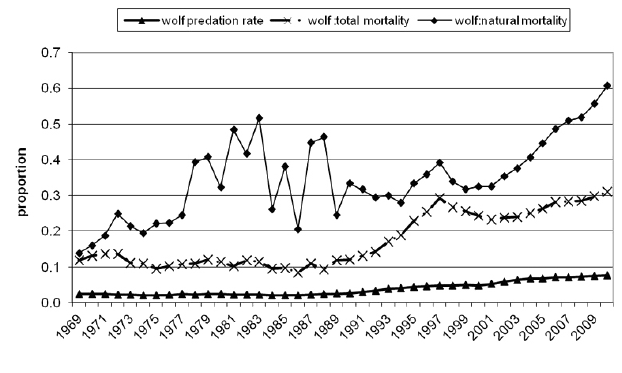
Fig. 8 . Predation rate by wolves where: “wolf predation rate” is proportion of total population size; “wolf:total mortality” is the proportion of total mortality attributed to wolves; “wolf: natural mortality” is the proportion of nonharvest mortality attributed to wolves. Wolf population estimates are derived from a number of systematic surveys in representative habitats (tundra versus taiga, for example) and extrapolated through expert opinion to the range of the Taimyr